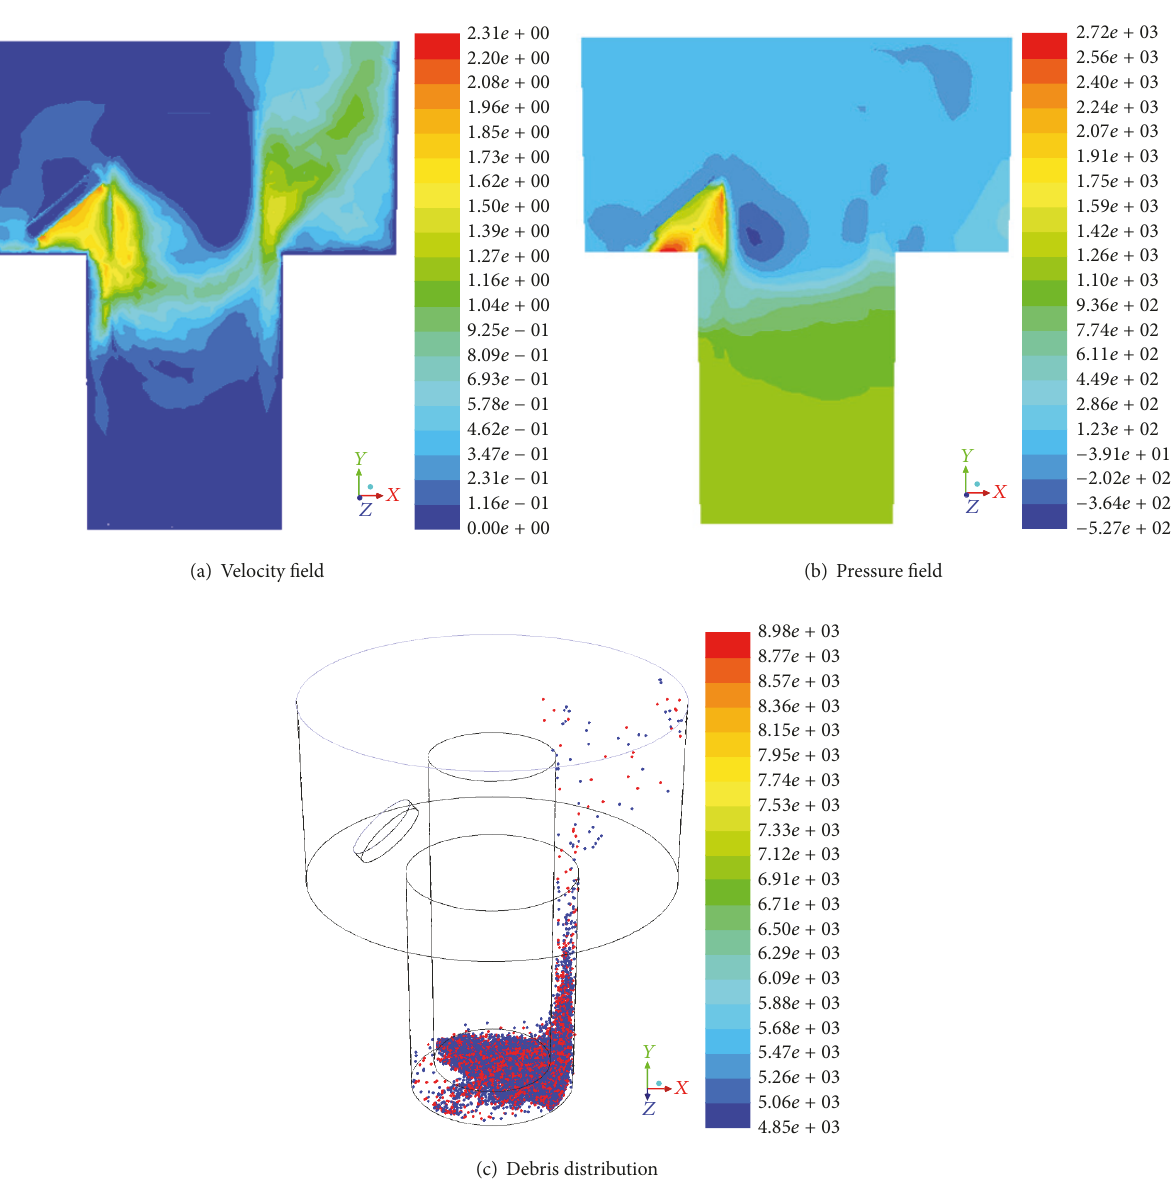
Figure 9: Schematics of gap flow field with flushing at 5 m/s and 2 mm deep